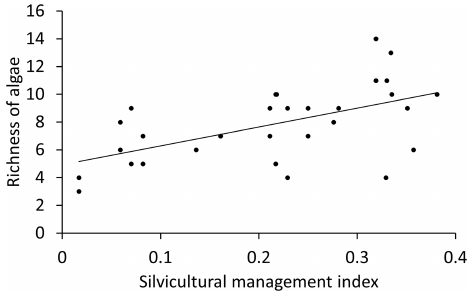
Figure 4. Plot of algae richness in BSCs from forests over the sil- vicultural management index (SMI). Natural forest has a low SMI, managed forests a high SMI; the line indicates the best linear fit (slope: 13.6, p < 0 . 001